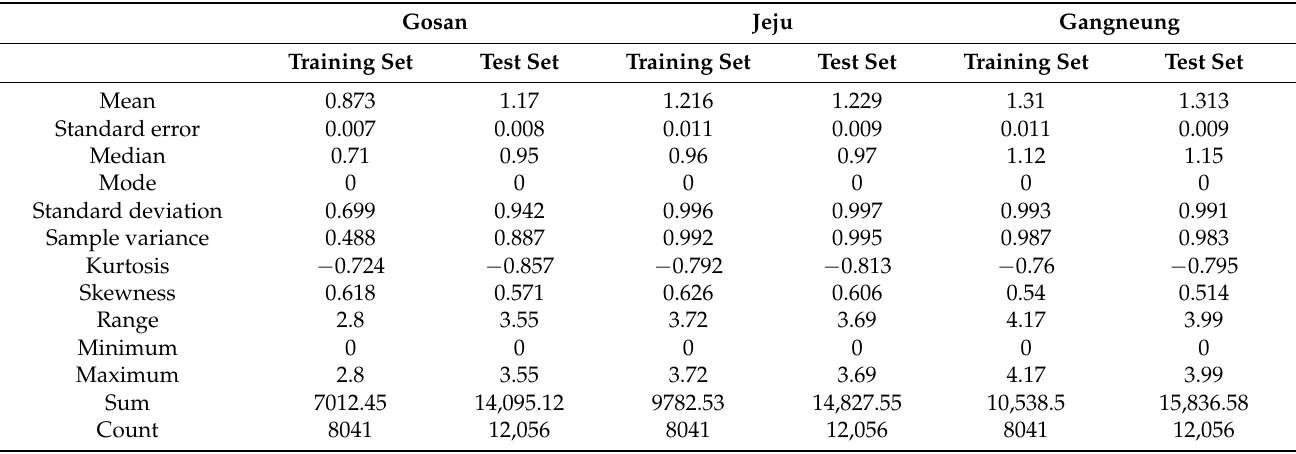
Table 2. Statistical analysis of the solar radiation data by region (MJ/m 2 ).